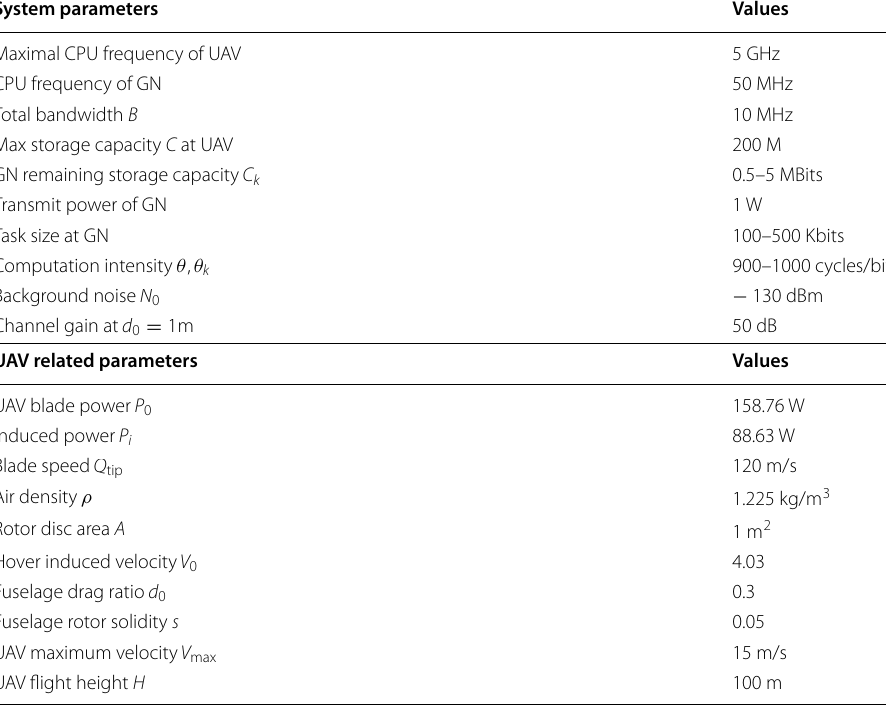
Table 1 Simulation parameters System